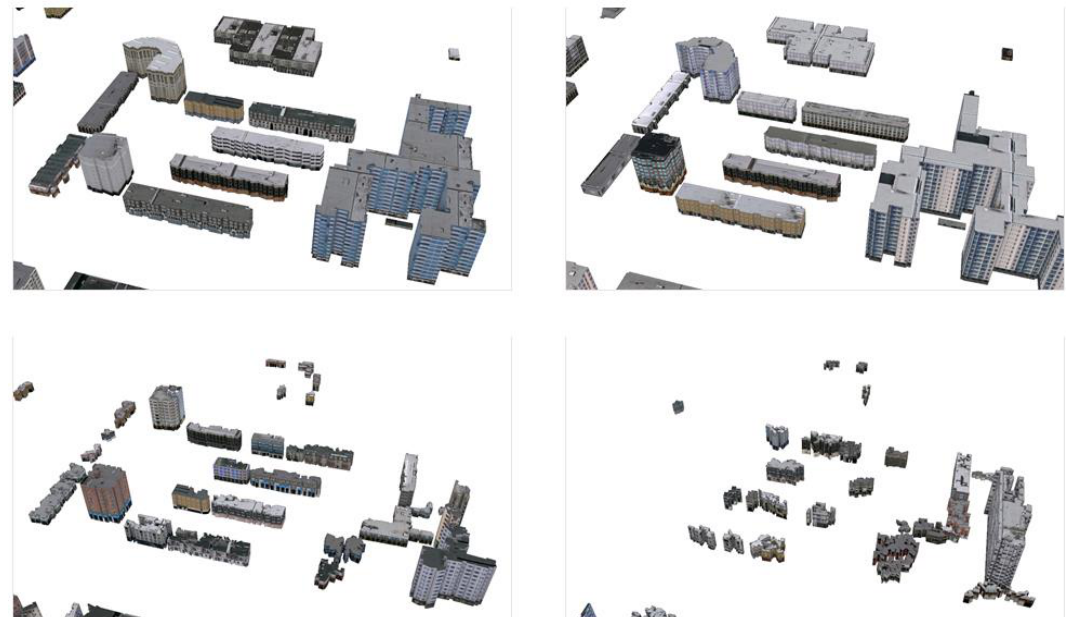
Figure 4: 3D building multipatches of Amsterdam reconstructed with ArcGIS API from the original point cloud (100% - top left) and its reduced versions (75% - top right, 50% - bottom left, 25% - bottom right).